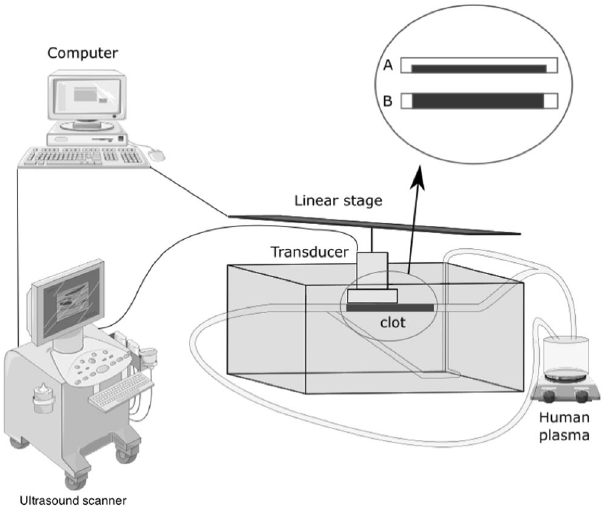
Figure 1. Schematic of in vitro setup for the thrombolysis experiments. Drawing of ultrasound scanner, computer and human plasma, have been obtained from Servier Medical Art of Servier under the Creative Commons Attribution 3.0 France